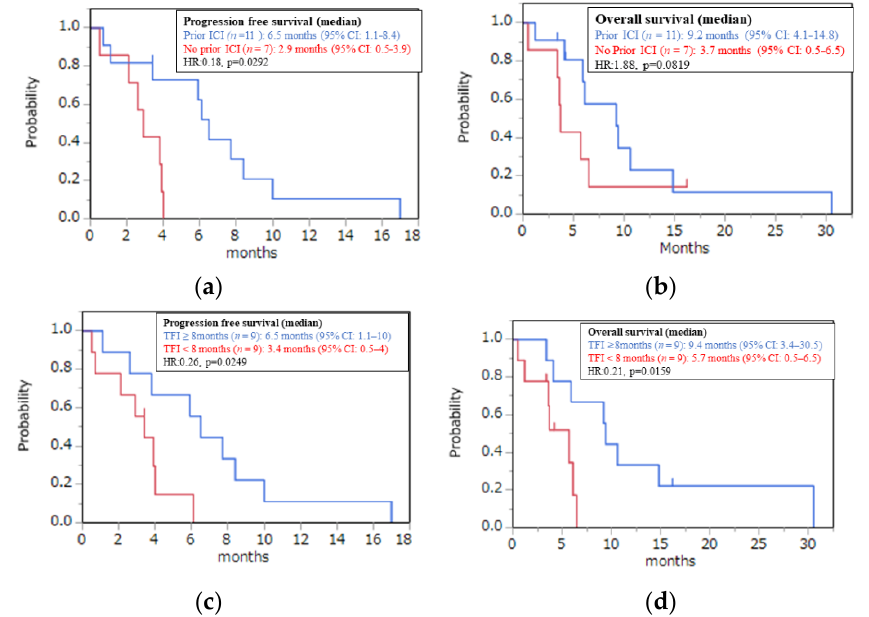
Figure 2. ( a ) PFS and ( b ) OS among study participants classified by prior therapy. Red line: No prior immune checkpoint inhibitor (ICI); blue line: prior ICI; Kaplan–Meier plots of ( c ) PFS and ( d ) OS among study participants. Red line: Tmab-free interval (TFI) < 8 months; blue line: TFI ≥ 8 months.